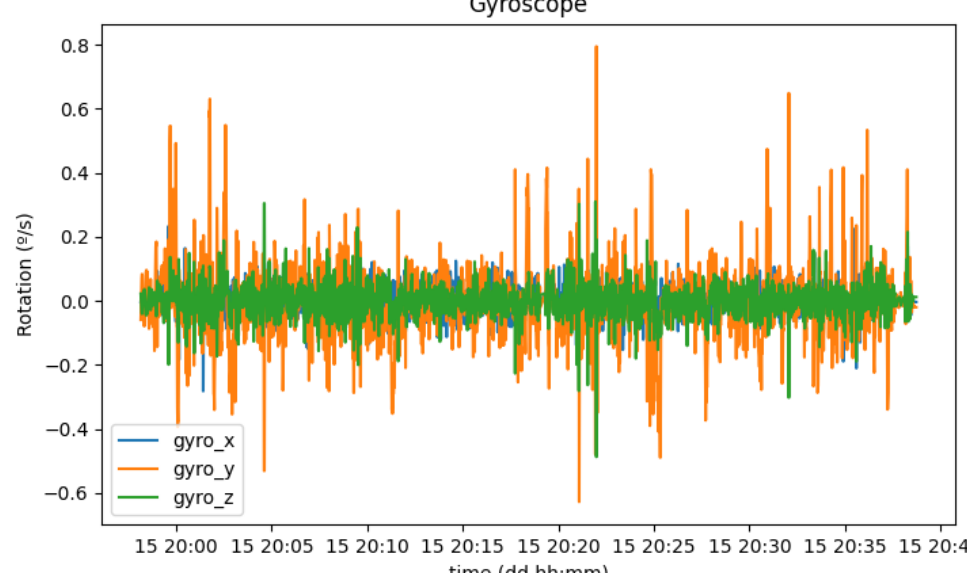
Figure 21. Rotation of the smartphone in each axis (x, y, and z).